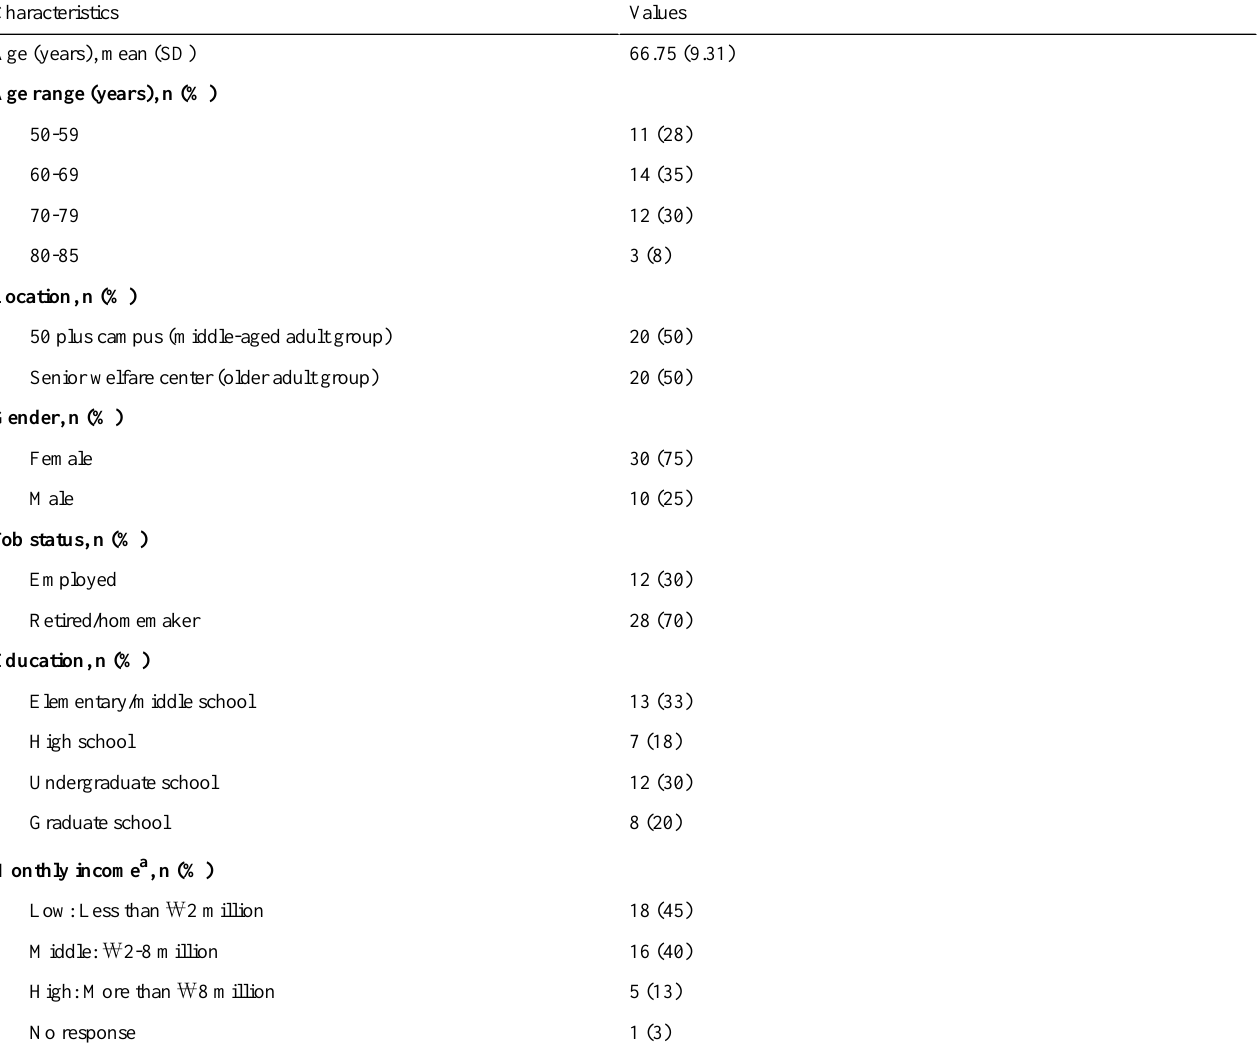
Table 1. Demographic information of the participants (N=40).